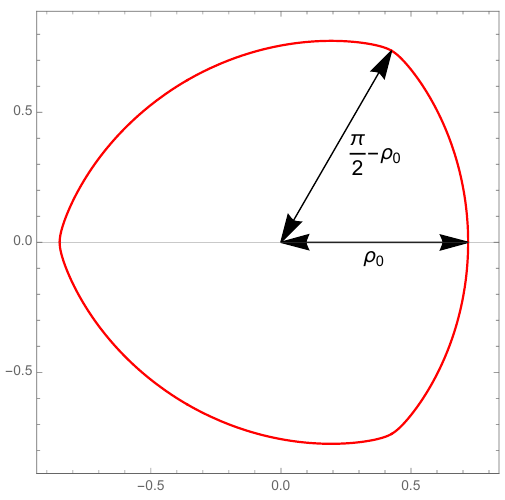
Figure 11 . Rounded spike solution for ρ 0 = 0 . 72 and ρ 1 ’ 0 . 86 . We call the turning points defined by ρ = π/ 2 − ρ rounded 0